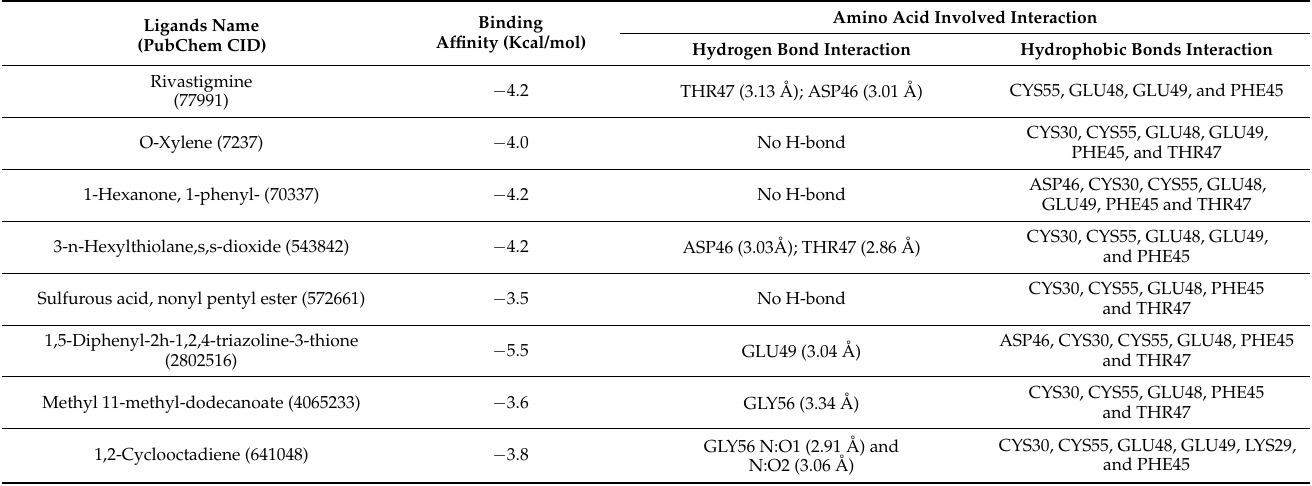
Table 4. The binding affinity of interested ligands with the targeted protein macromolecule and comprehensive intermolec- ular